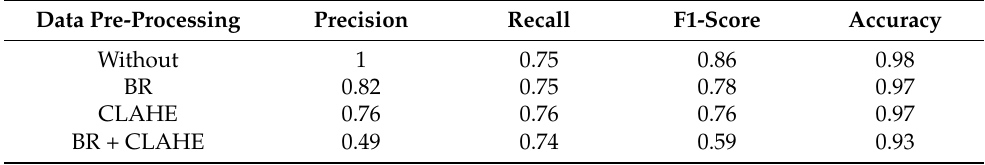
Table 4. Experimental results at the image